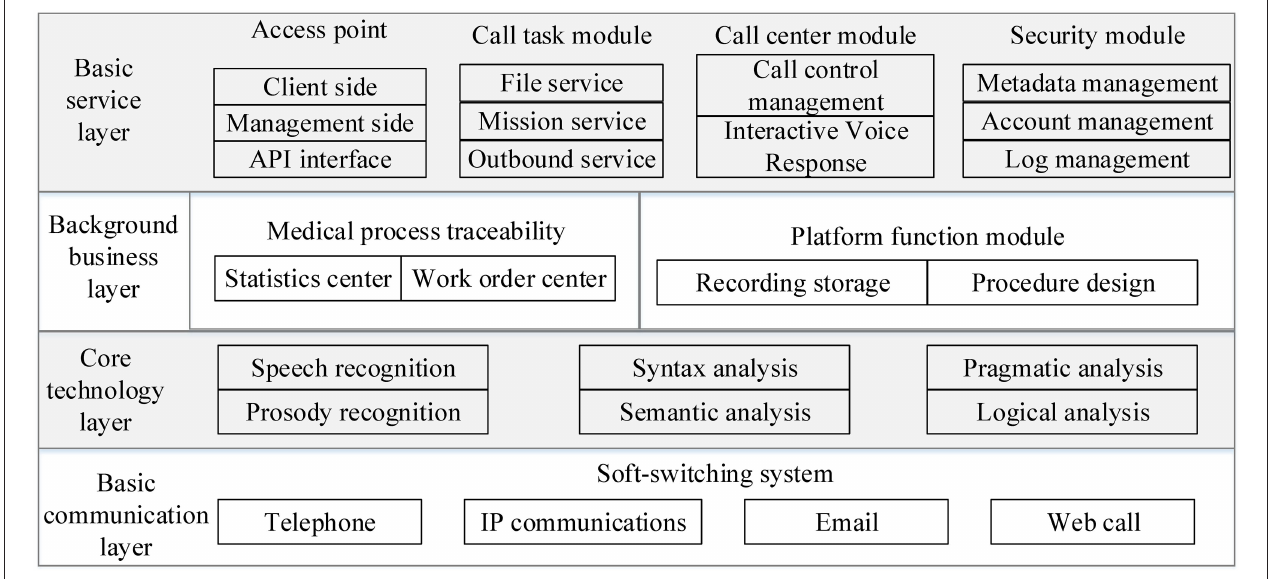
FIGURE 2 | System